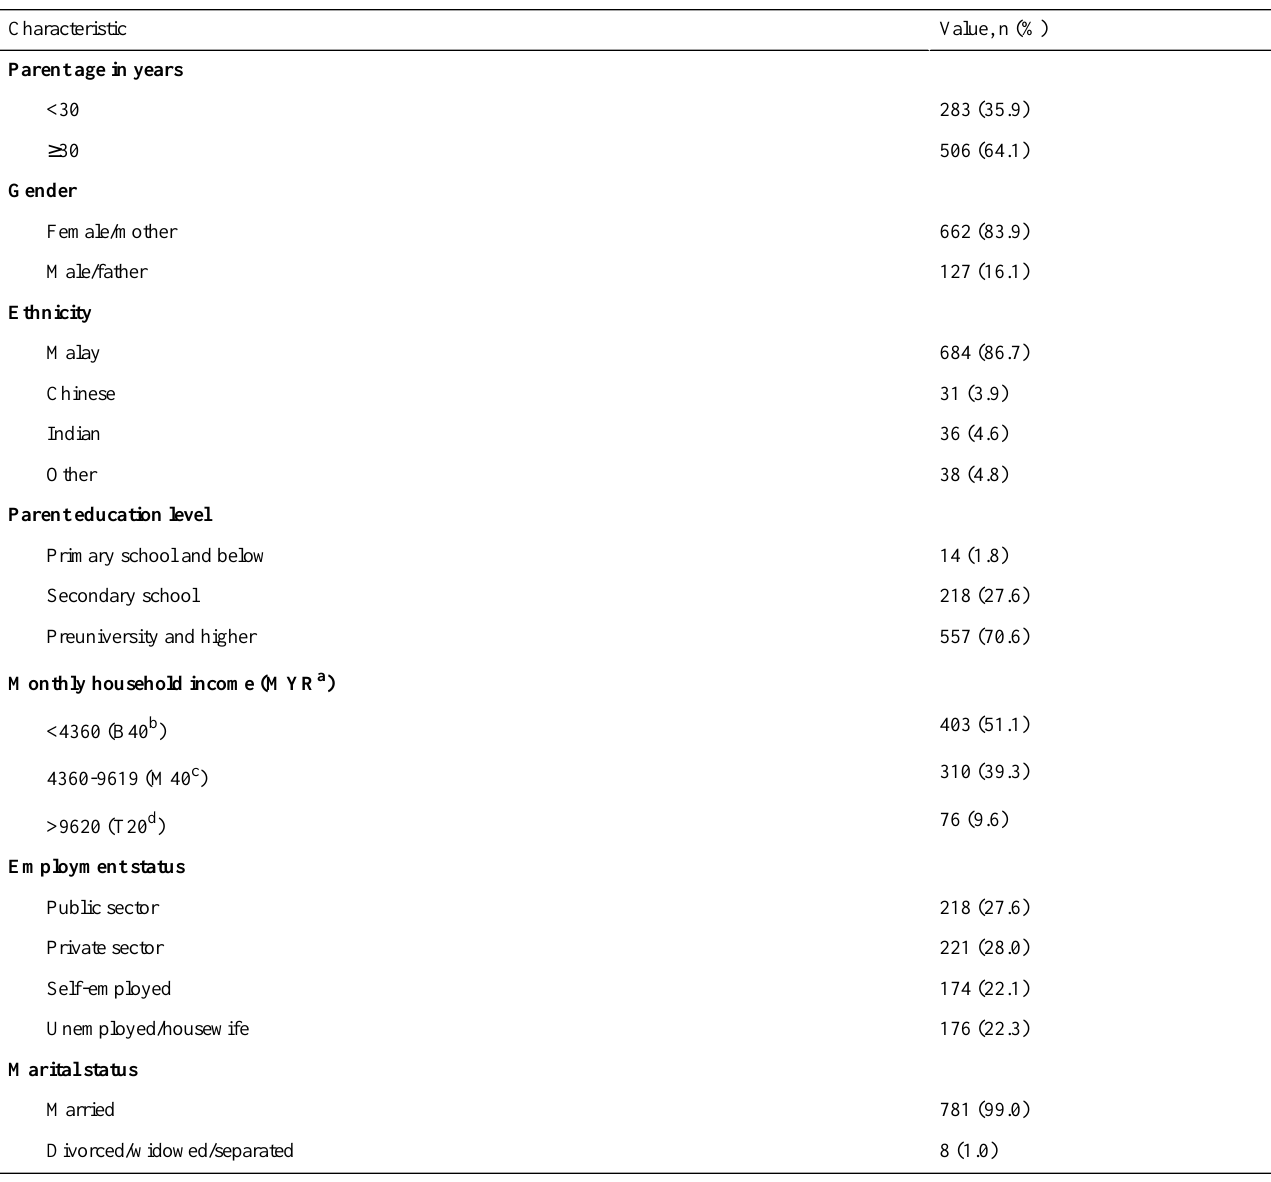
Table 1. Distribution of respondents according to sociodemographic factors